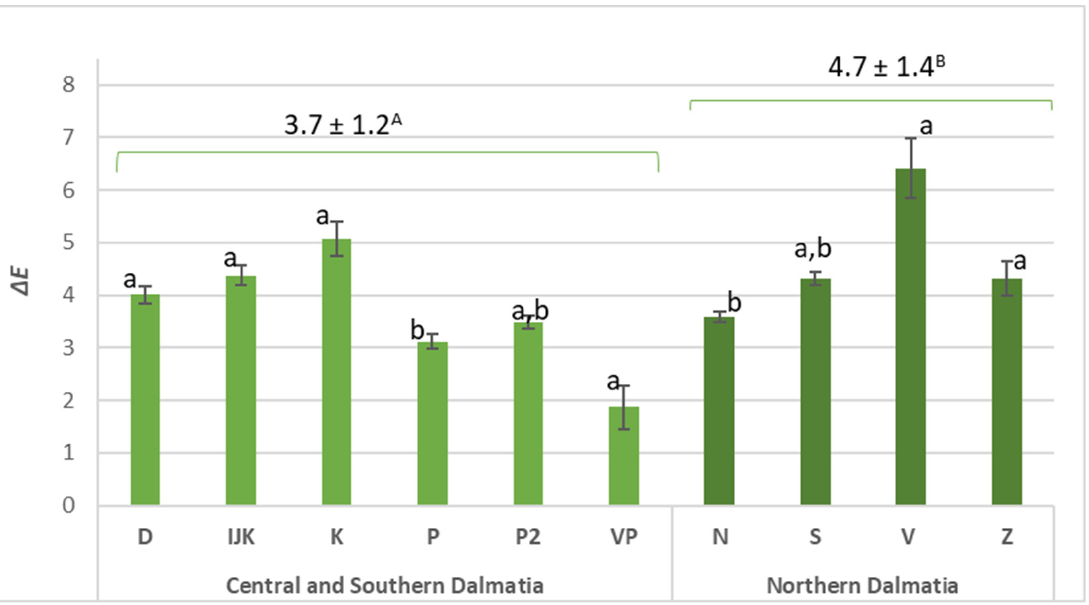
Figure 3. Colour changes ( Δ E) between musts and their wines. Different letters denote significant differences among the vineyards (means ± SEs), and capital letters indicate regional differences (both at p < 0.05).